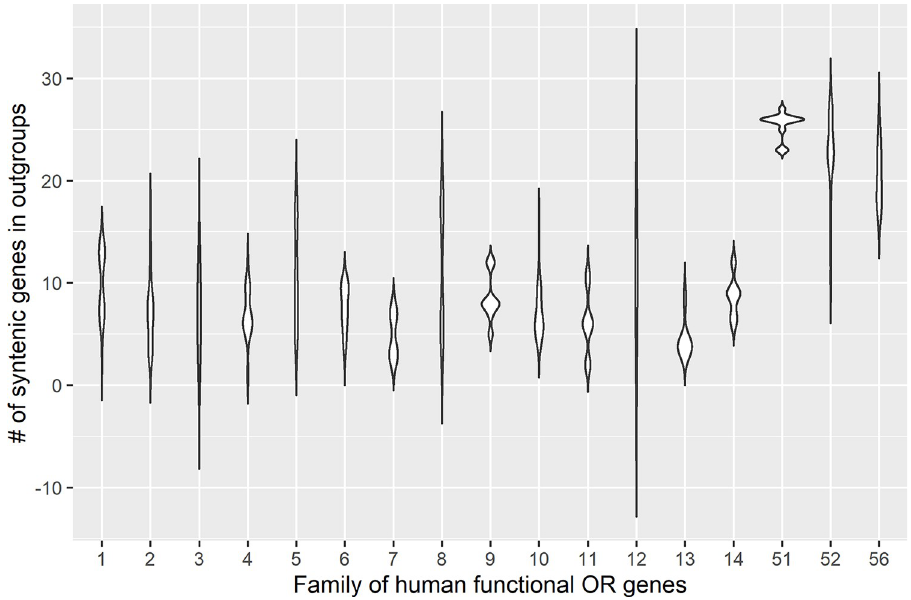
Fig 5. Families of human functional OR genes significantly differ in the number of syntenic genes in the outgroup species. Comparison of numbers of syntenic genes in outgroups species among families of human functional OR genes. The comparison was statistically significant ( P = 1.42 × 10 − 30 ) based on Kruskal–Wallis